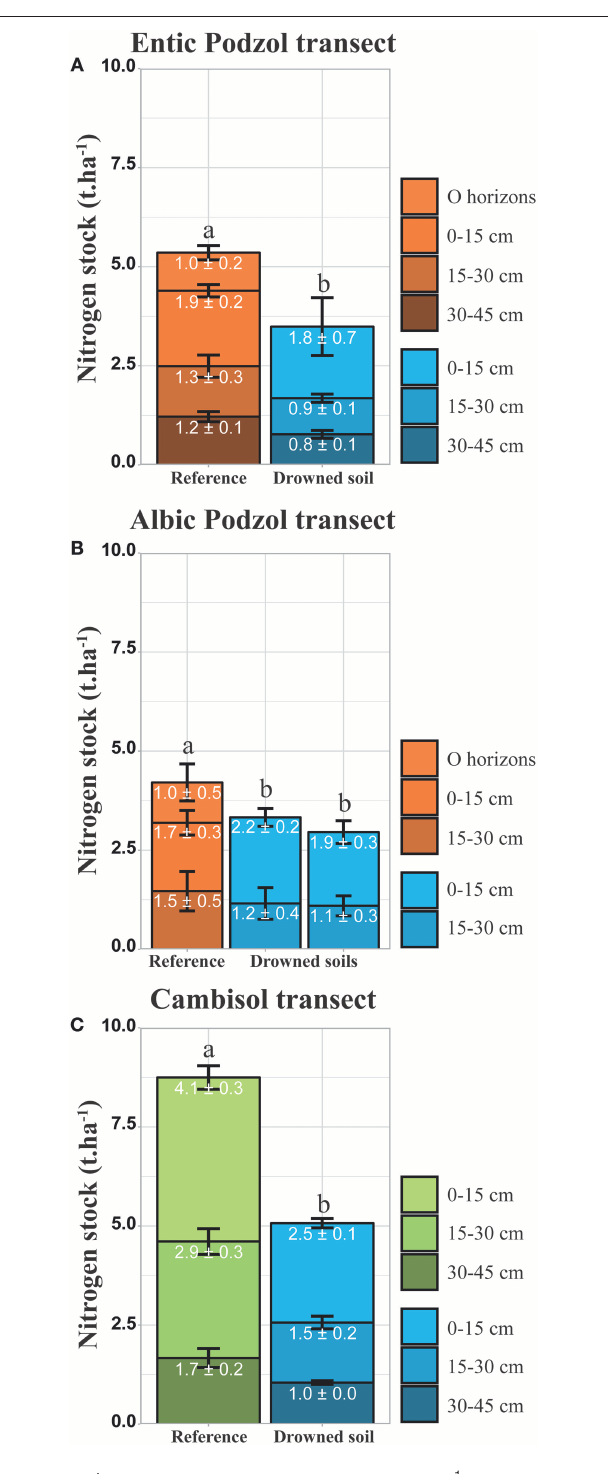
FIGURE 6 | Bar plots of the average nitrogen stocks (t.ha − 1 ) by depth, down to 45cm for Entic Podzol (A) and Cambisol (C) and 30cm for Albic Podzol (B) (see text). Error bars represent ± 1 sd. Average stock values at each depth are given ± 1 sd. Statistical differences were calculated by transect using TukeyHSD test. Entic Podzol: p -values < 0.05. Albic Podzol: p -values < 0.05. Cambisol: p -values <